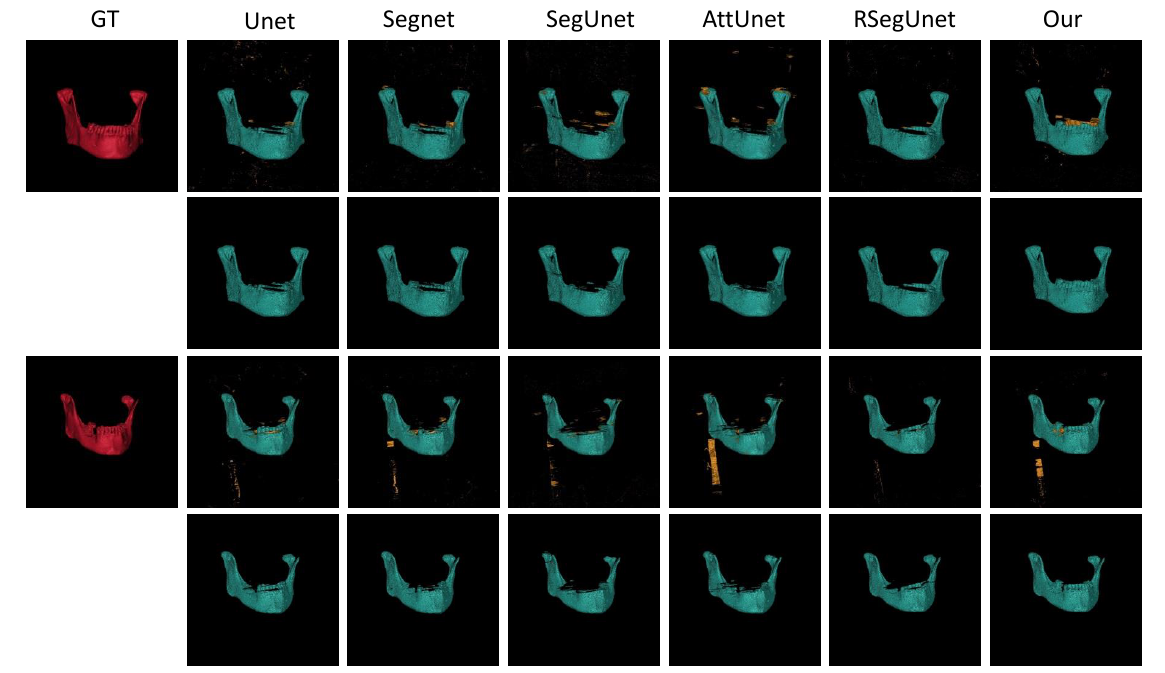
Figure 7. Visual 3D examples of final segmentations from the CT dataset. From left to right: Ground truth (GT), Unet, Segnet, SegUnet, AttUnet, RSegUnet, and the proposed method.